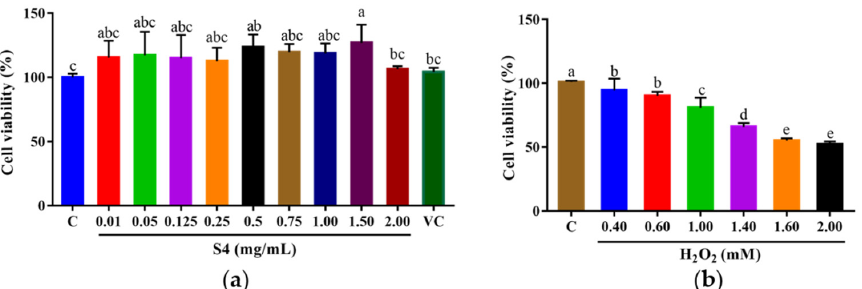
Figure 4. Cell viabilities of HepG2 cells treated with ( a ) S4 peptide or V C and ( b ) H 2 O 2 at different concentrations. “C” represents the control group. Data were expressed as mean ± SD ( n ≥ 3, p < 0.05). Different letters indicate significant differences ( p < 0.05).